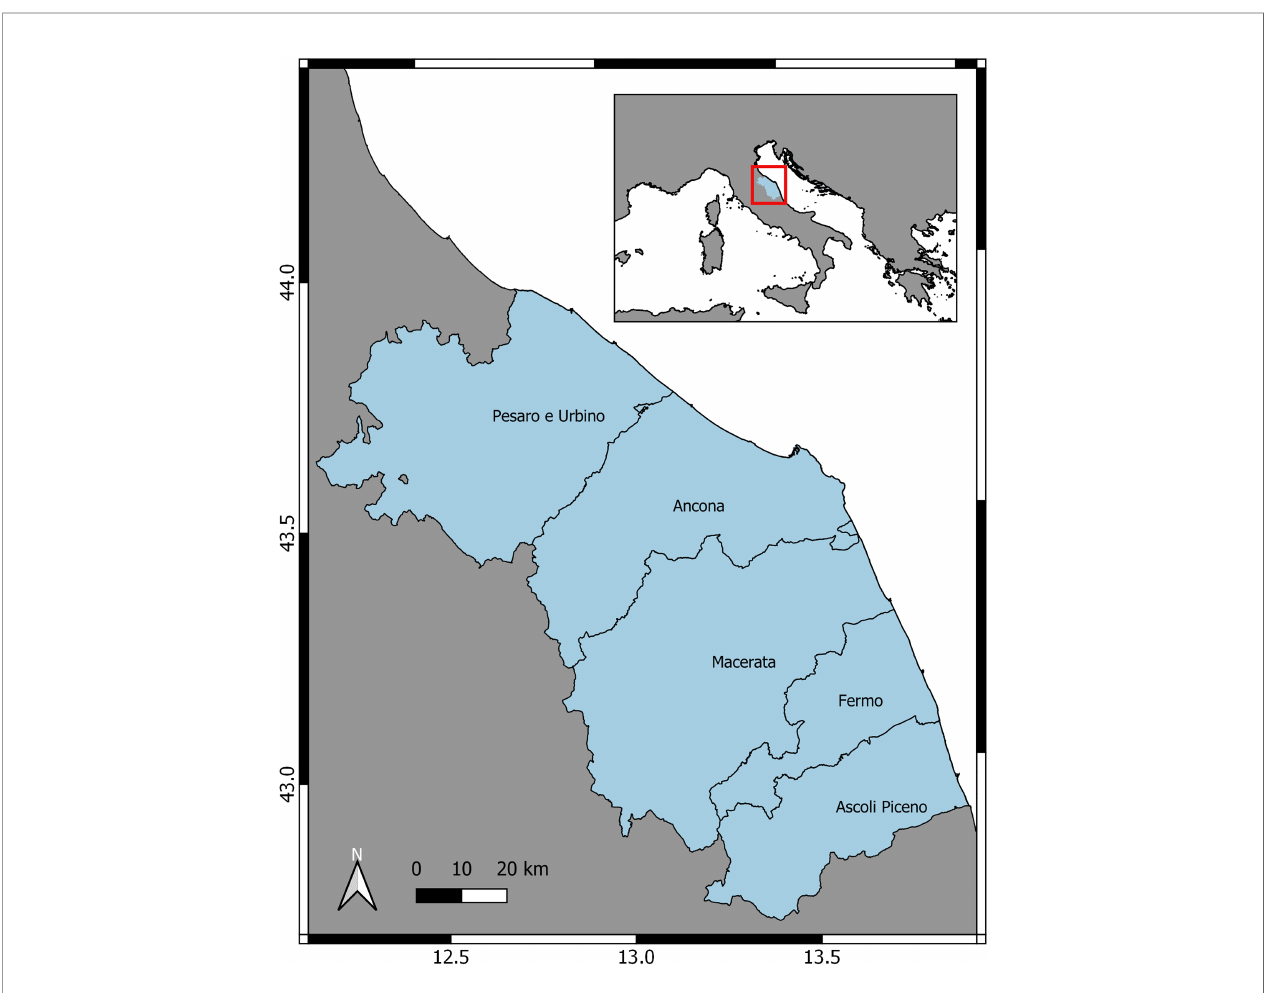
FIGURE 1 | Marche region and its provinces